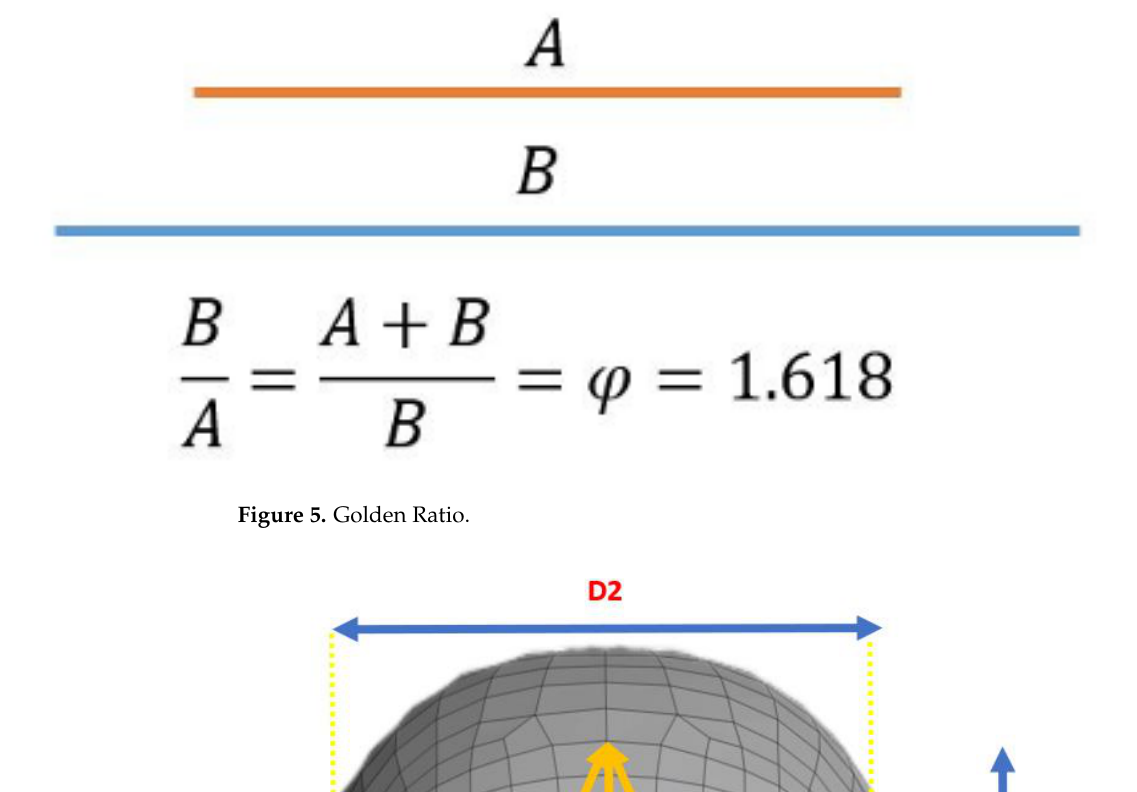
Figure 6. Facial geometrics features used in Table 3. Table 3. Proposed 23 golden facial geometric features. Feature